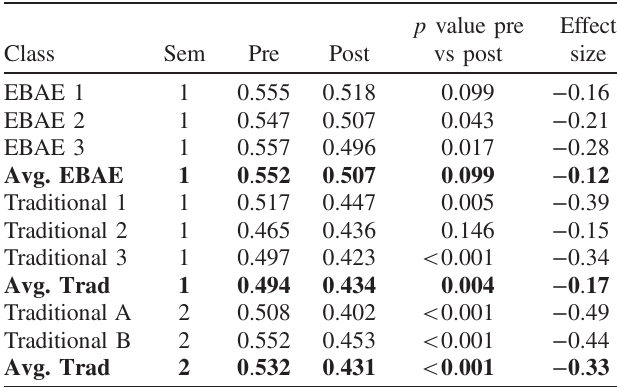
TABLE III. p values obtained via the t tests comparing the average pre- and post-AAPS survey scores, and effect sizes for the decline in scores from the pre- to post-AAPS survey.